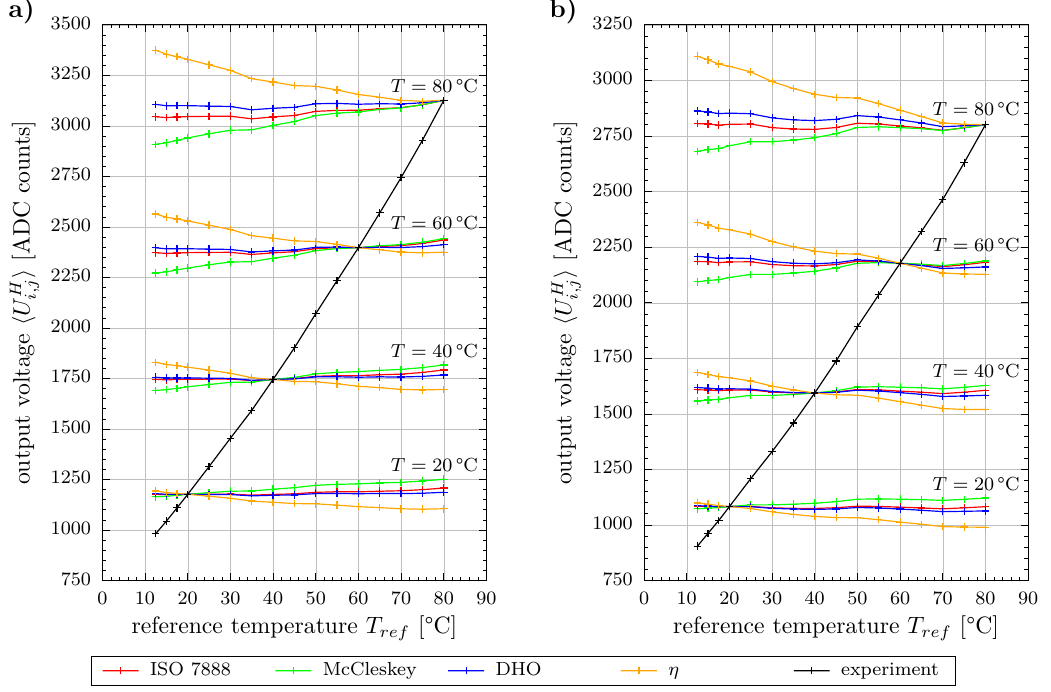
Figure 5. Application of temperature compensation to cross-sectional average of measured output voltages for ( a ) deionized water and ( b ) water